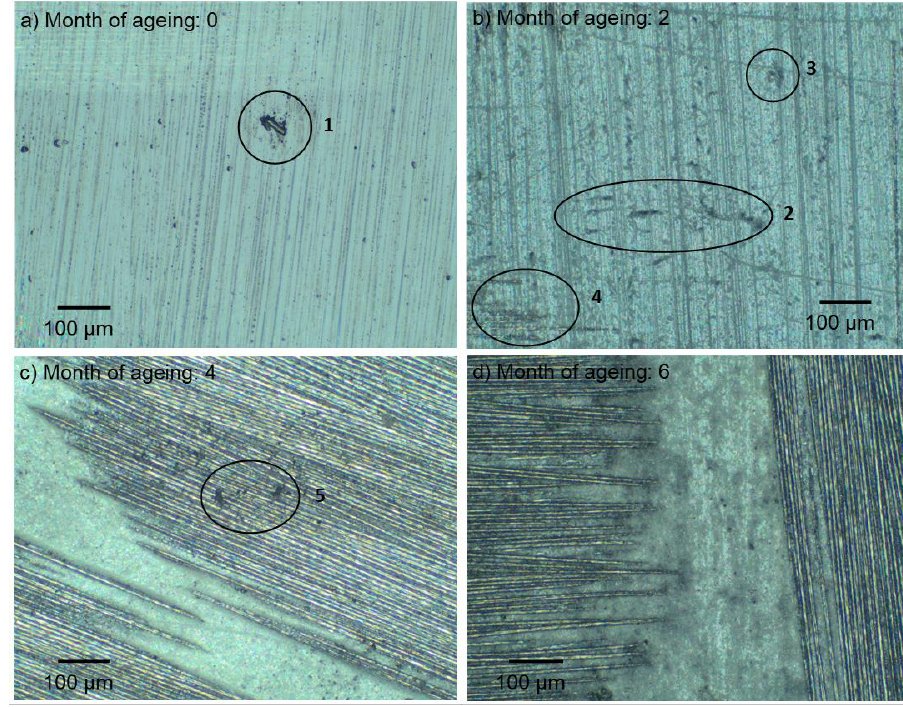
Figure 3. Microscopic image of the examined sample surface prior to abrasive wear after ( a ) 0, ( b ) 2, ( c ) 4, and ( d ) 6 months of weathering.